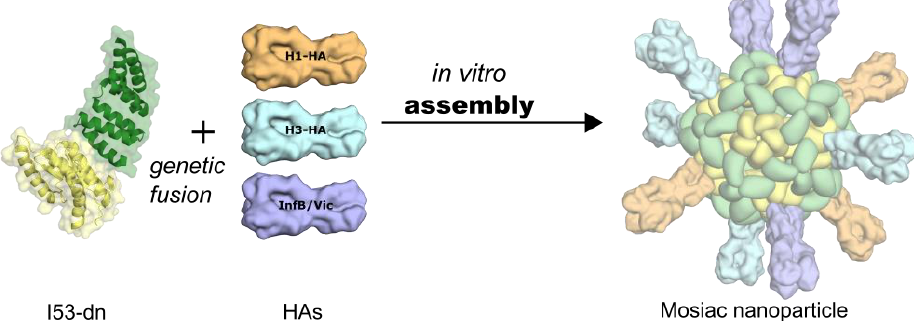
Figure 5. De novo design of self-assembling mosaic nanoparticles displaying various HA